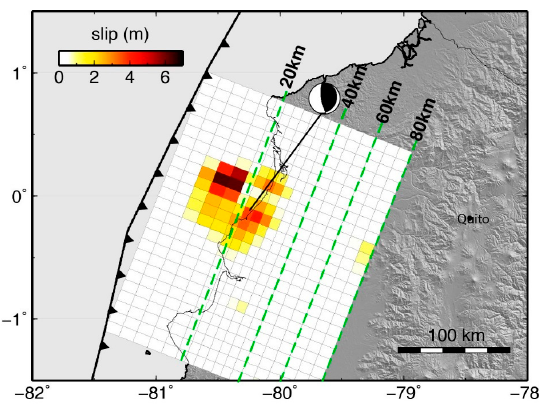
Figure 4. Coseismic slip distribution on the subduction interface from inversion of Sentinel-1 and GPS data. Colours show the magnitude of slip in metres. Depths on the fault plane are shown as green dashed lines.